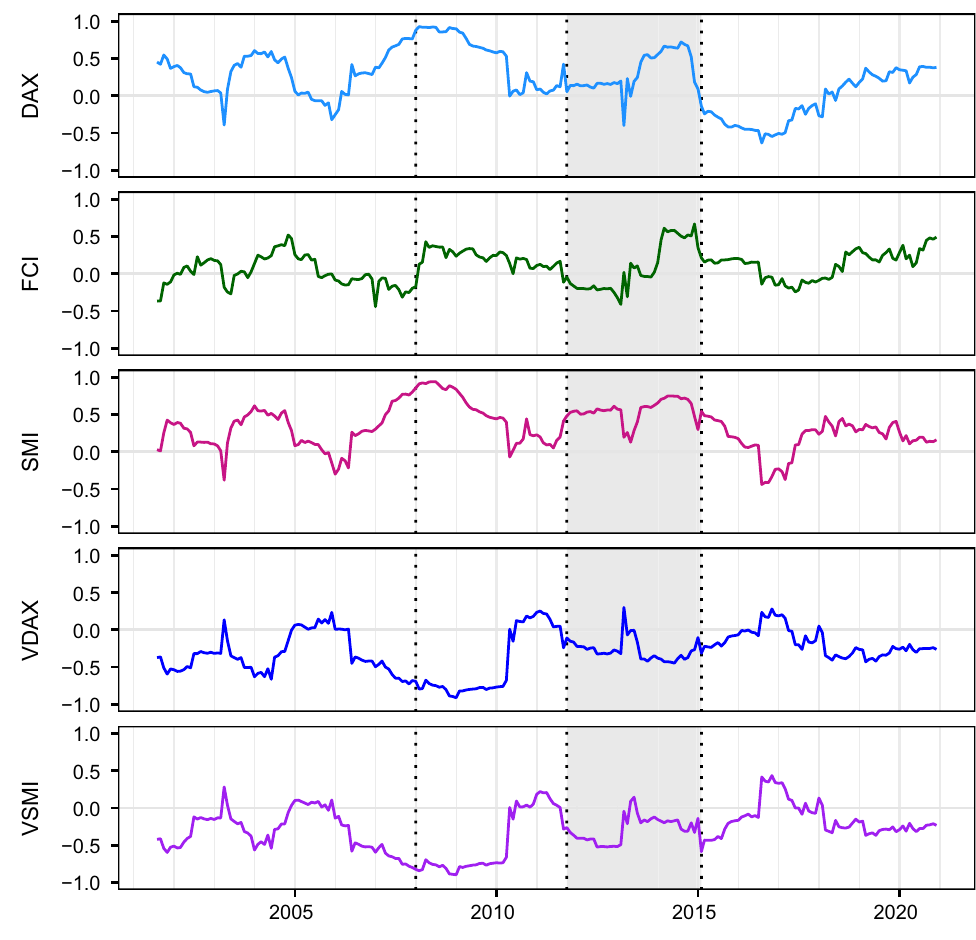
Fig. 4 Rolling window correlations (part 1) between explanatory variables and the EUR/CHF exchange rate for a window size of 18 months. Dotted lines indicate the estimated breakpoints. The shaded area marks the peg